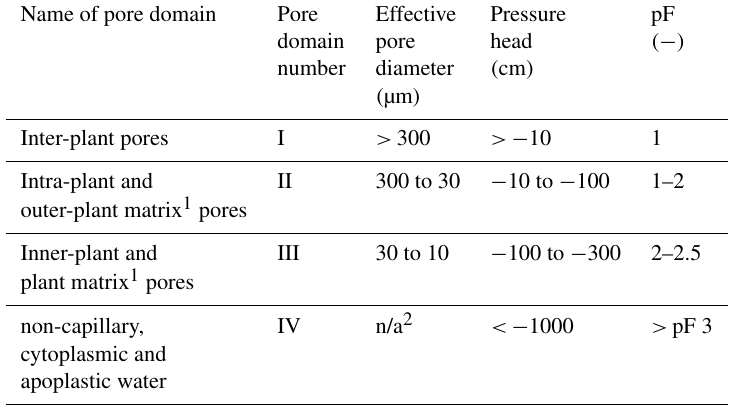
Table 4. Overview of the proposed pore domain nomenclature with corresponding pressure head delimitations and effective pore diameters.